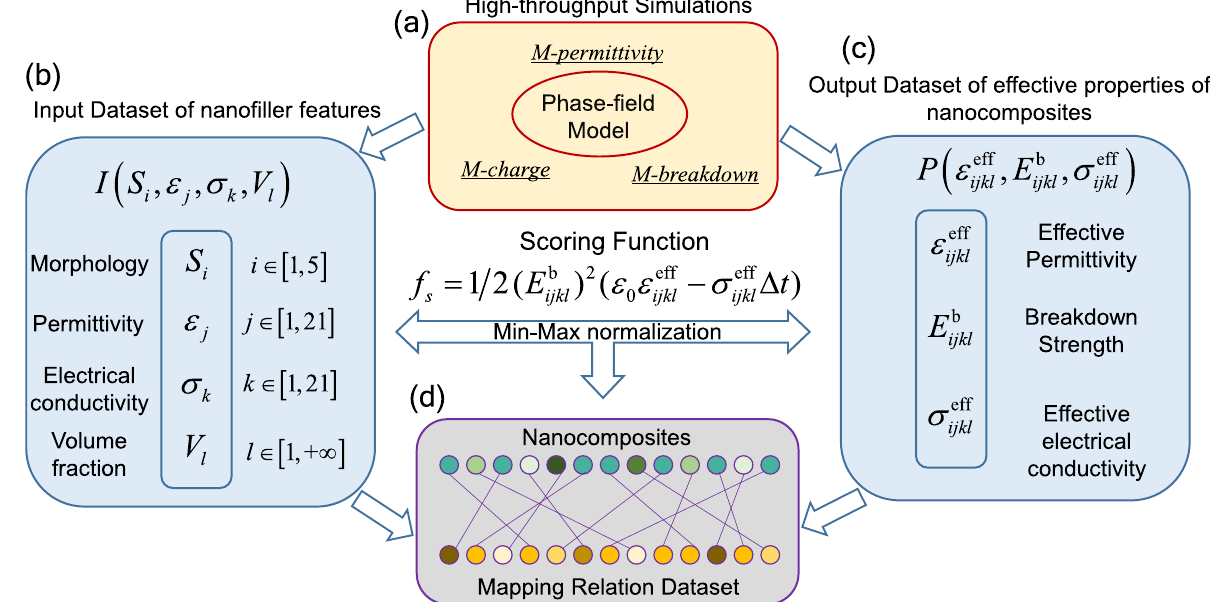
Fig. 4 Schematic work fl ow of high-throughput phase- fi eld simulations and machine learning strategy. a High-throughput phase- fi eld simulations. b Input data set of nano fi ller features with the variables of morphology, permittivity, electrical conductivity, and volume fraction. c Output data set of effective properties of nanocomposites including the effective permittivity, breakdown strength, and effective electrical conductivity. d The microstructure-property data set of